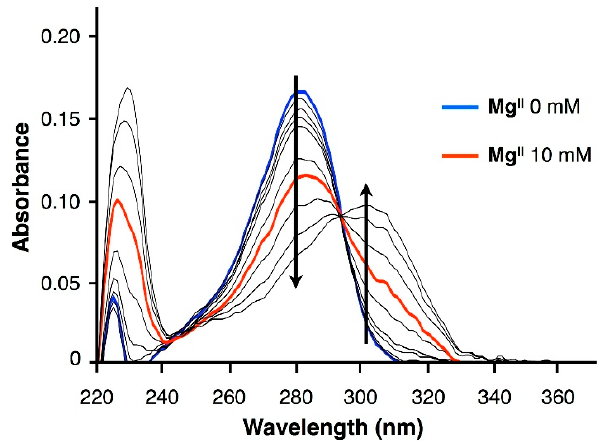
Figure 1. Ultraviolet-visible (UV) spectral changes of hydroxypyridone-bearing nucleoside triphosphate (d H TP) at various concentrations of Mg II ions. d H TP: 100 µM, Mg II : 0, 0.1, 0.5, 1.0, 2.0, 5.0, 10, 20, 50, and 100 mM, in 25 mM MOPS (3-( N -morpholino)propanesulfonic acid) buffer and 100 mM, in 25 mM MOPS (3-( N -morpholino)propanesulfonic acid) buffer (pH = 7.0), l = 0.1 cm, at (pH = 7.0), l = 0.1 cm, at room temperature. Blue line: 0 mM, red line: 10 mM, black lines: 0.1, 0.5, room temperature. Blue line: 0 mM, red line: 10 mM, black lines: 0.1, 0.5, 1.0, 2.0, 5.0, 20, 50, and 100 mM. 1.0, 2.0, 5.0, 20, 50, and 100 mM. Arrows indicate the changes in the absorbance upon increasing the Arrows indicate the changes in the absorbance upon increasing the Mg II